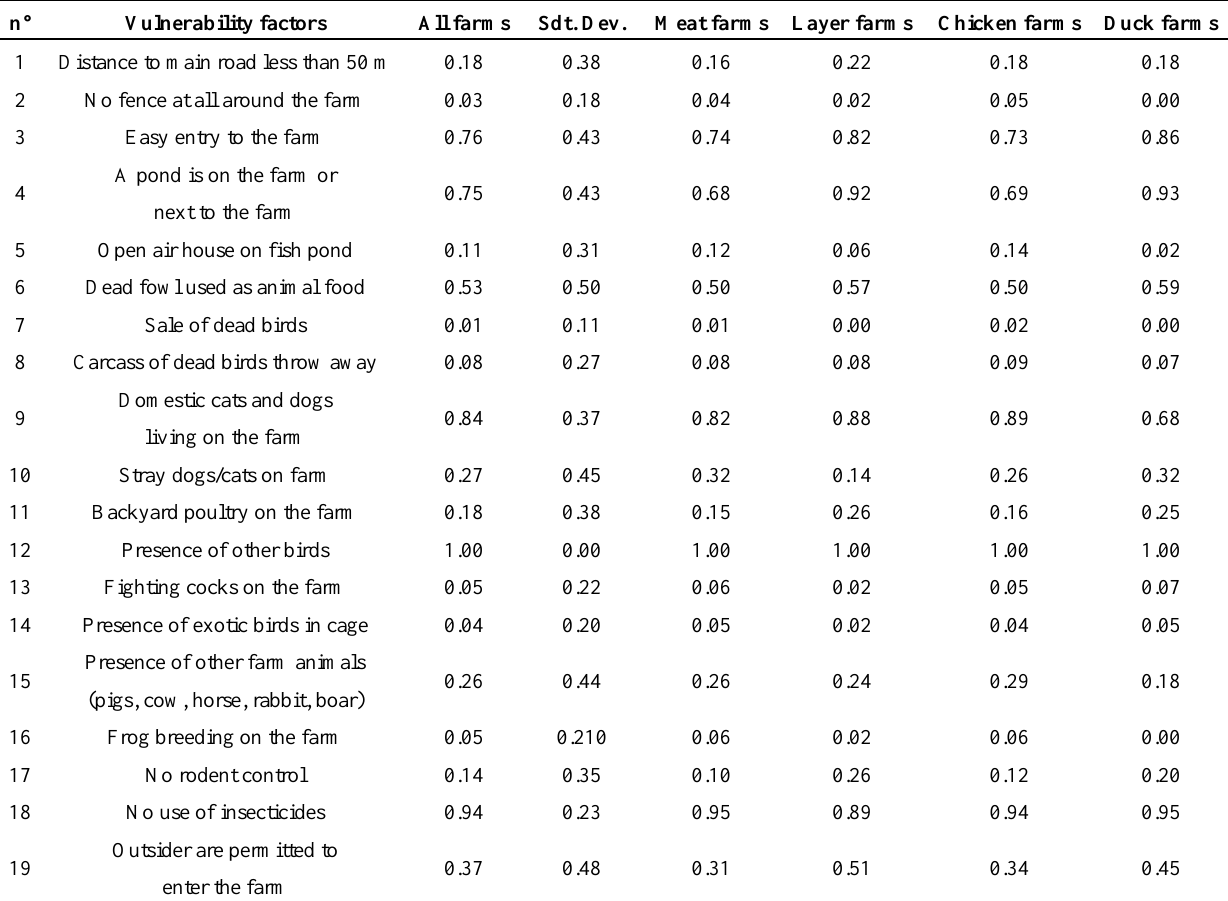
Table 2. Results of the survey by factor: proportion of yes answers, standard deviation, results by type of production (meat or layer) or type of bird (chicken or